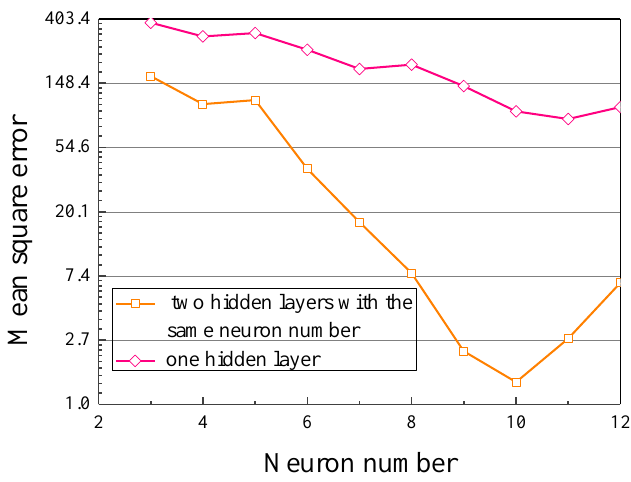
Figure 6. The influences of the hidden layer number and neuron number in each hidden layer on the generalization performance of the neural network.